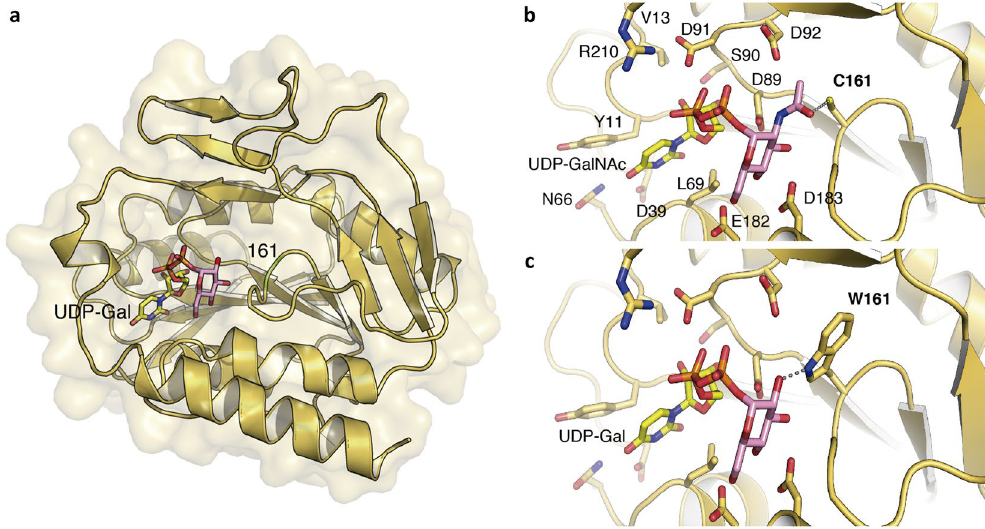
Figure 5. Three-Dimensional modeling of CpsK polymorphic variants. ( a ) The serotype 2 CpsK protein structure is depicted in yellow ribbon, and the position of amino acid residue 161 was colored in green and labeled. The docked substrate UDP-Gal is shown in sticks with the Gal moiety in pink. ( b ) Detailed view of the catalytic center of protein CpsK from serotype 1/2 with a cysteine residue at position 161 (C161) in complex with UDP-GalNAc as a substrate. Residues predicted to play a role in substrate binding and stabilization are depicted as capped sticks and labeled. Potential hydrogen bond between C161 and N -acetyl group of GalNAc is represented with a dashed grey line. ( c ) Same view as in panel a for the catalytic center of protein CpsK from serotype 2 with a tryptophan residue at position 161 (W161) in complex with UDP-Gal molecule as a substrate. Dashed grey line represents the potential hydrogen bond between W161 and the hydroxyl group of